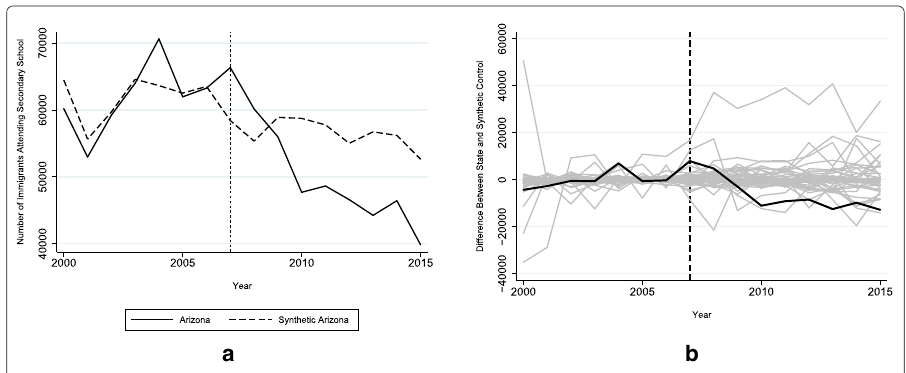
simulate a distribution of differences between each state in the donor pool and its